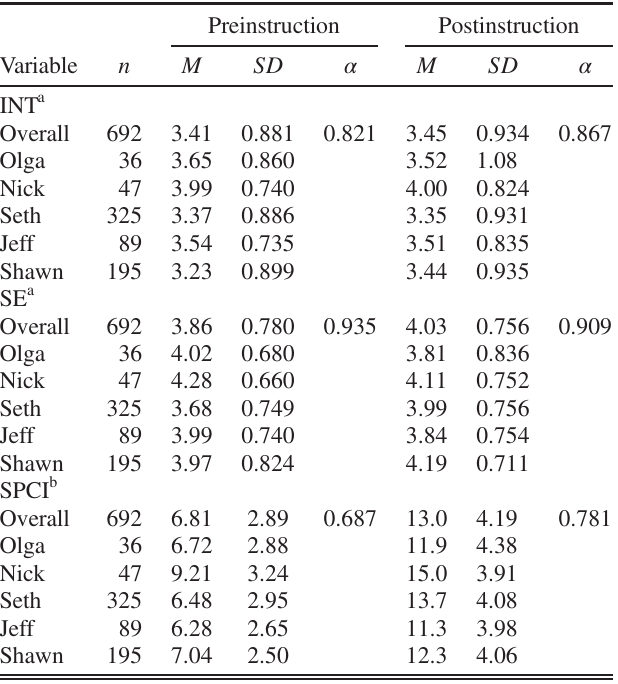
TABLE IV. Descriptive statistics for the study